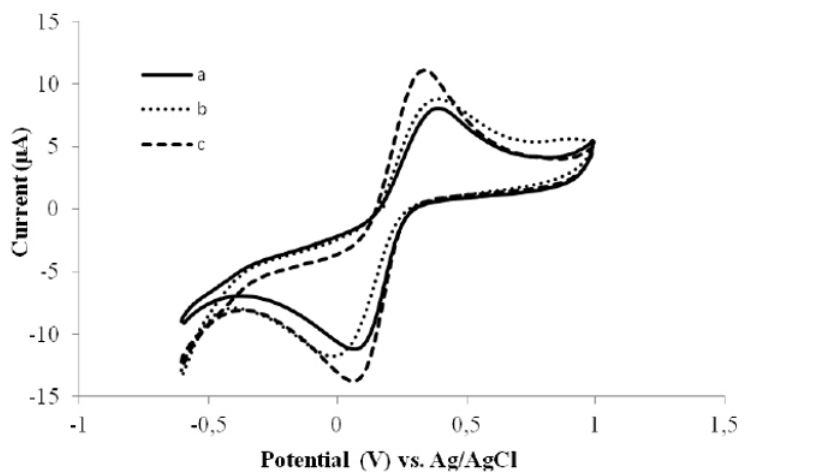
Figure 1. Cyclic voltammograms in 10 -6 mM K